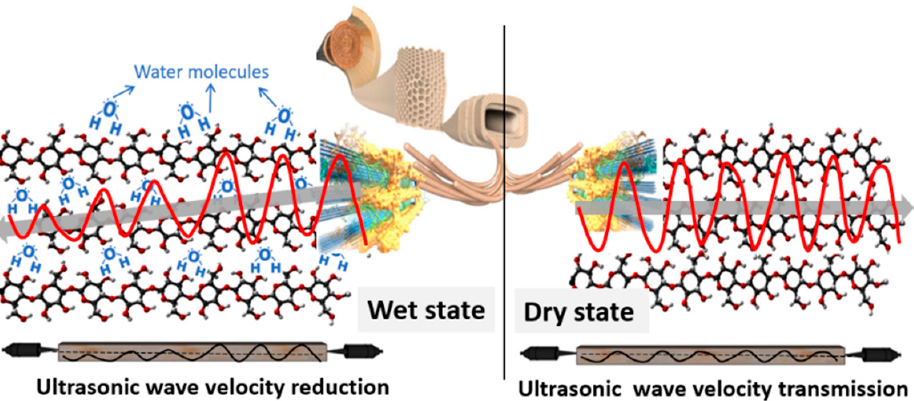
Figure 1. Representation of ultrasound velocity TOF measurement in the longitudinal direction and explaining wood structure in different scales to visualize the phenomenon of wave propagation and the affectation by water molecules. Central figure adapted from